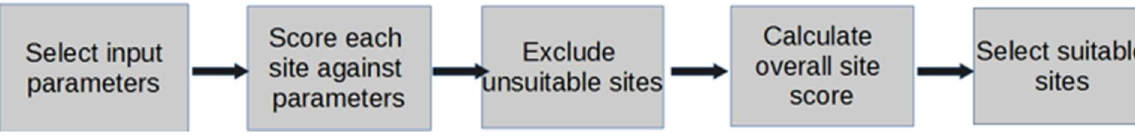
Figure 2. Diagram showing the typical structure of the multicriteria decision method (source: [71]). Reproduced from [71], the name of the publisher: ePrints Soton 2017.